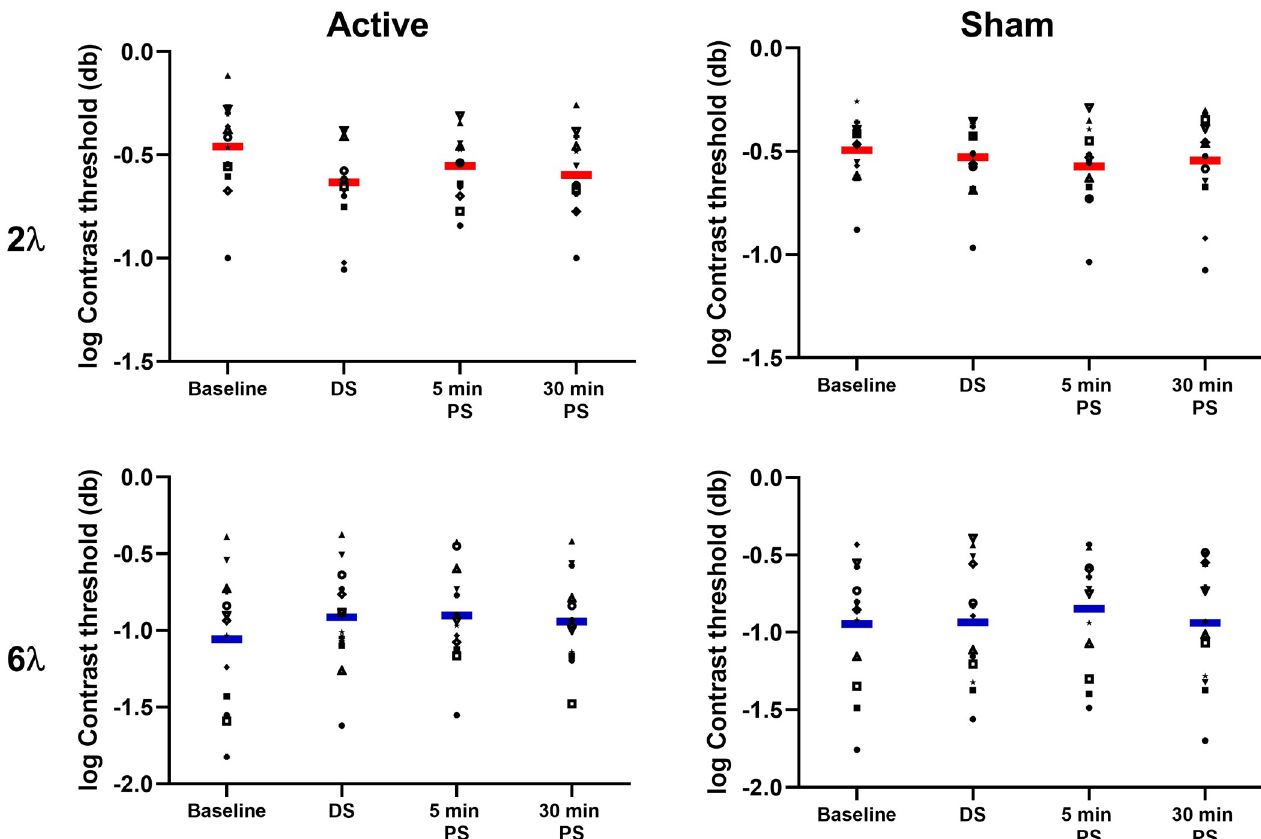
Fig 2. Contrast threshold. Log contrast detection thresholds (db) for each participant for the 2 λ (top row) and 6 λ (bottom row) flanker separations during the active (left column) and sham (right column) stimulation sessions.